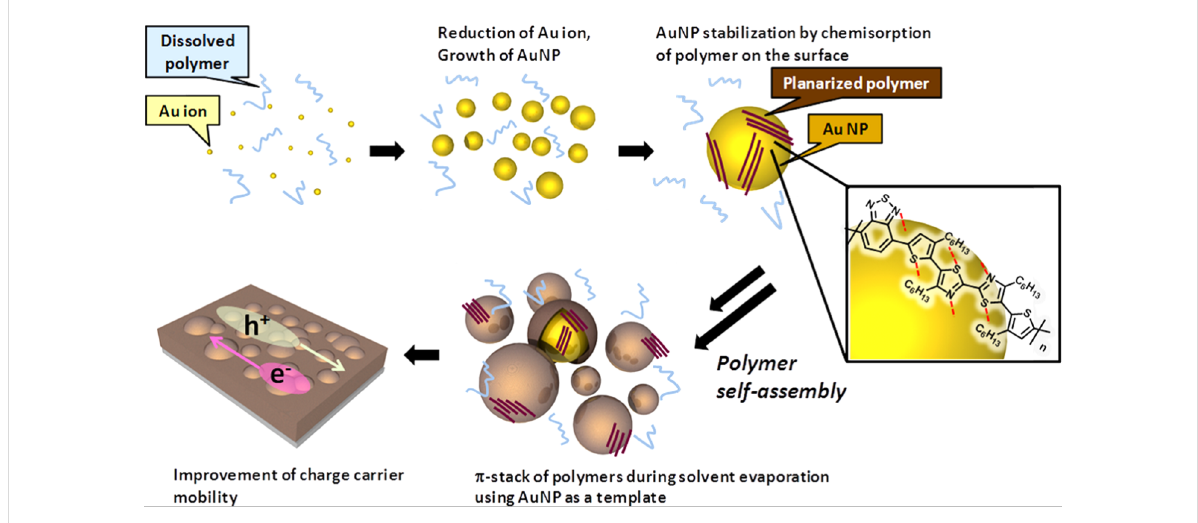
Figure 8: Formation of gold nanoparticles in a bithiazole–benzothiazole-based polymer matrix and their role as a template for the self-assembly of the bulk polymer leading to enhancement of the charge-carrier mobility. Reprinted with permission from [141], copyright 2012 American Chemical Society.